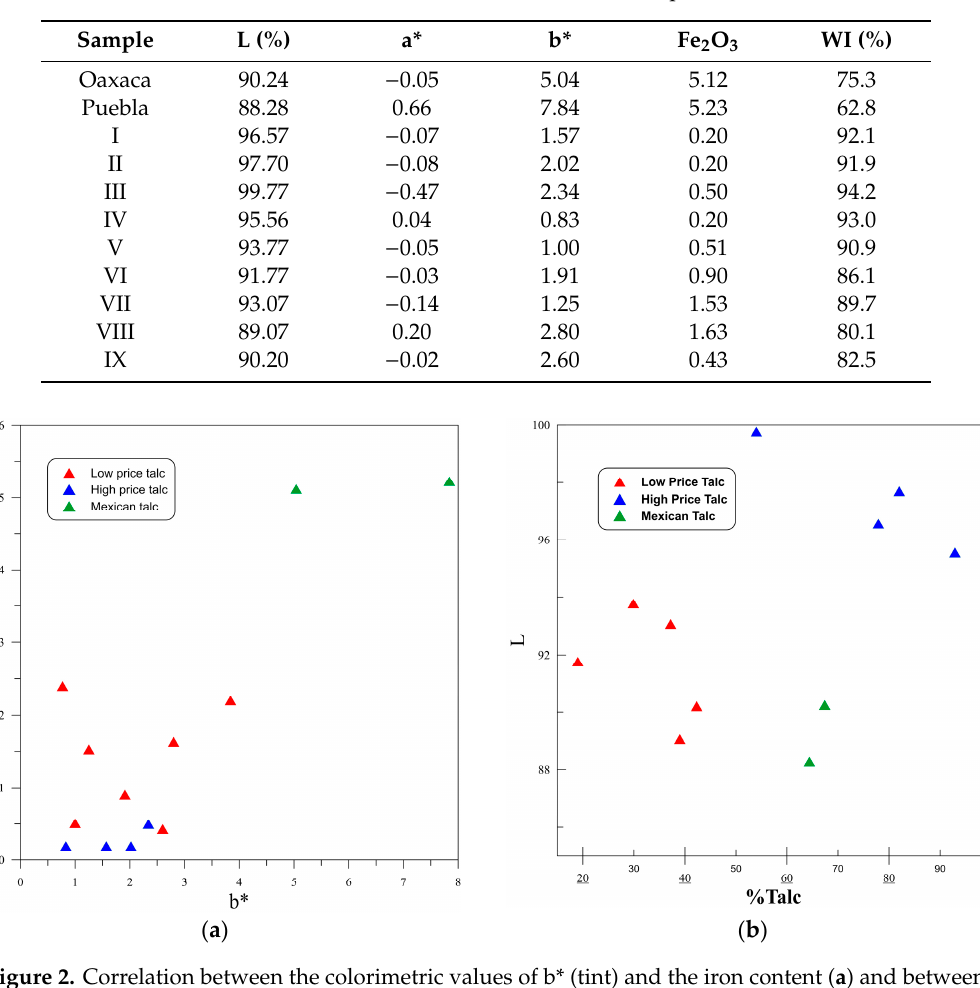
Figure 2. Correlation between the colorimetric values of b* (tint) and the iron content ( a ) and between luminosity (L%) and the amount of talc in the sample ( b ).